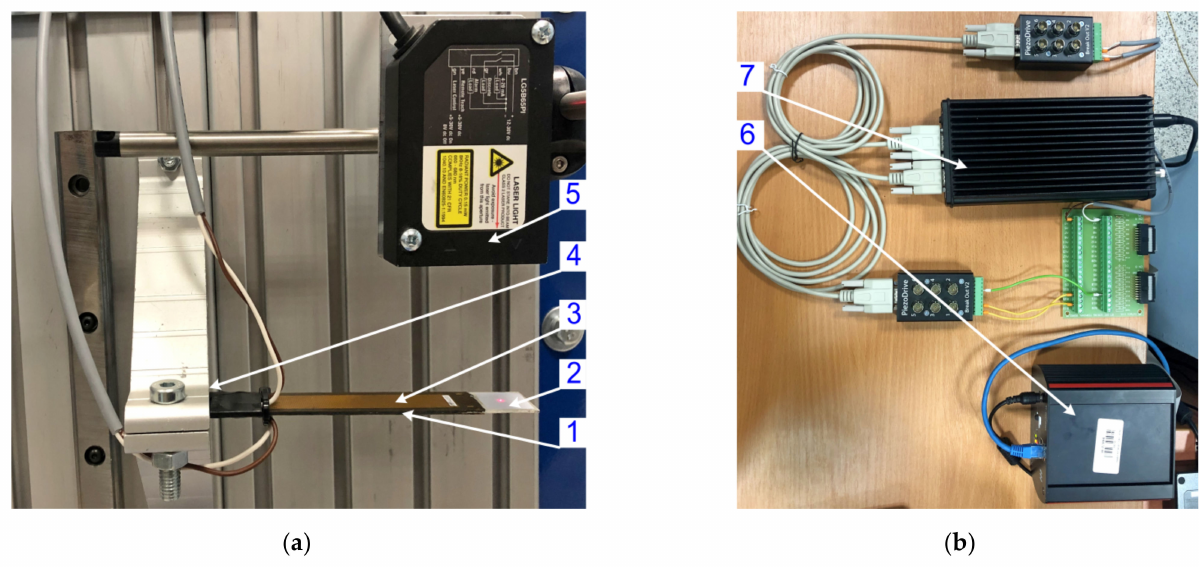
Figure 3. View of laboratory stand: ( a ) Actuator; ( b ) Main elements of control system. Tested beam actuator consisted of three layers: carrying substrate (2), MFC patch of P1 type (1) glued on bottom side of substrate and MFC patch of P1 type (3) glued on upper side of substrate. Whole beam structure was mounted in clamping assembly (4).